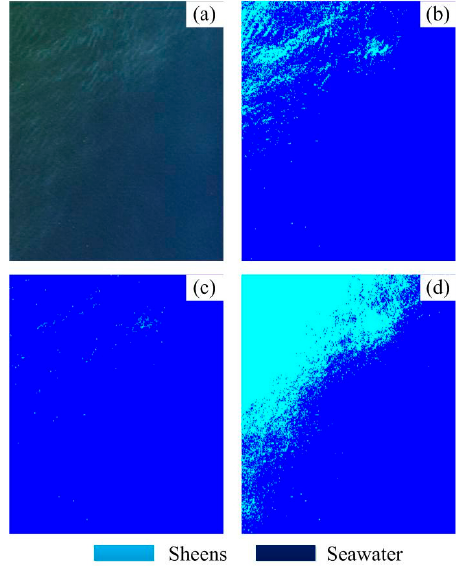
Figure 10. Images ( b – d ) are identification results for seawater and sheens; cyan pixels represent identified sheens and blue pixels represent seawater. Photo ( a ) is the original training image, and ( b – d ) are identification results for FI, RR, and CHL, respectively.